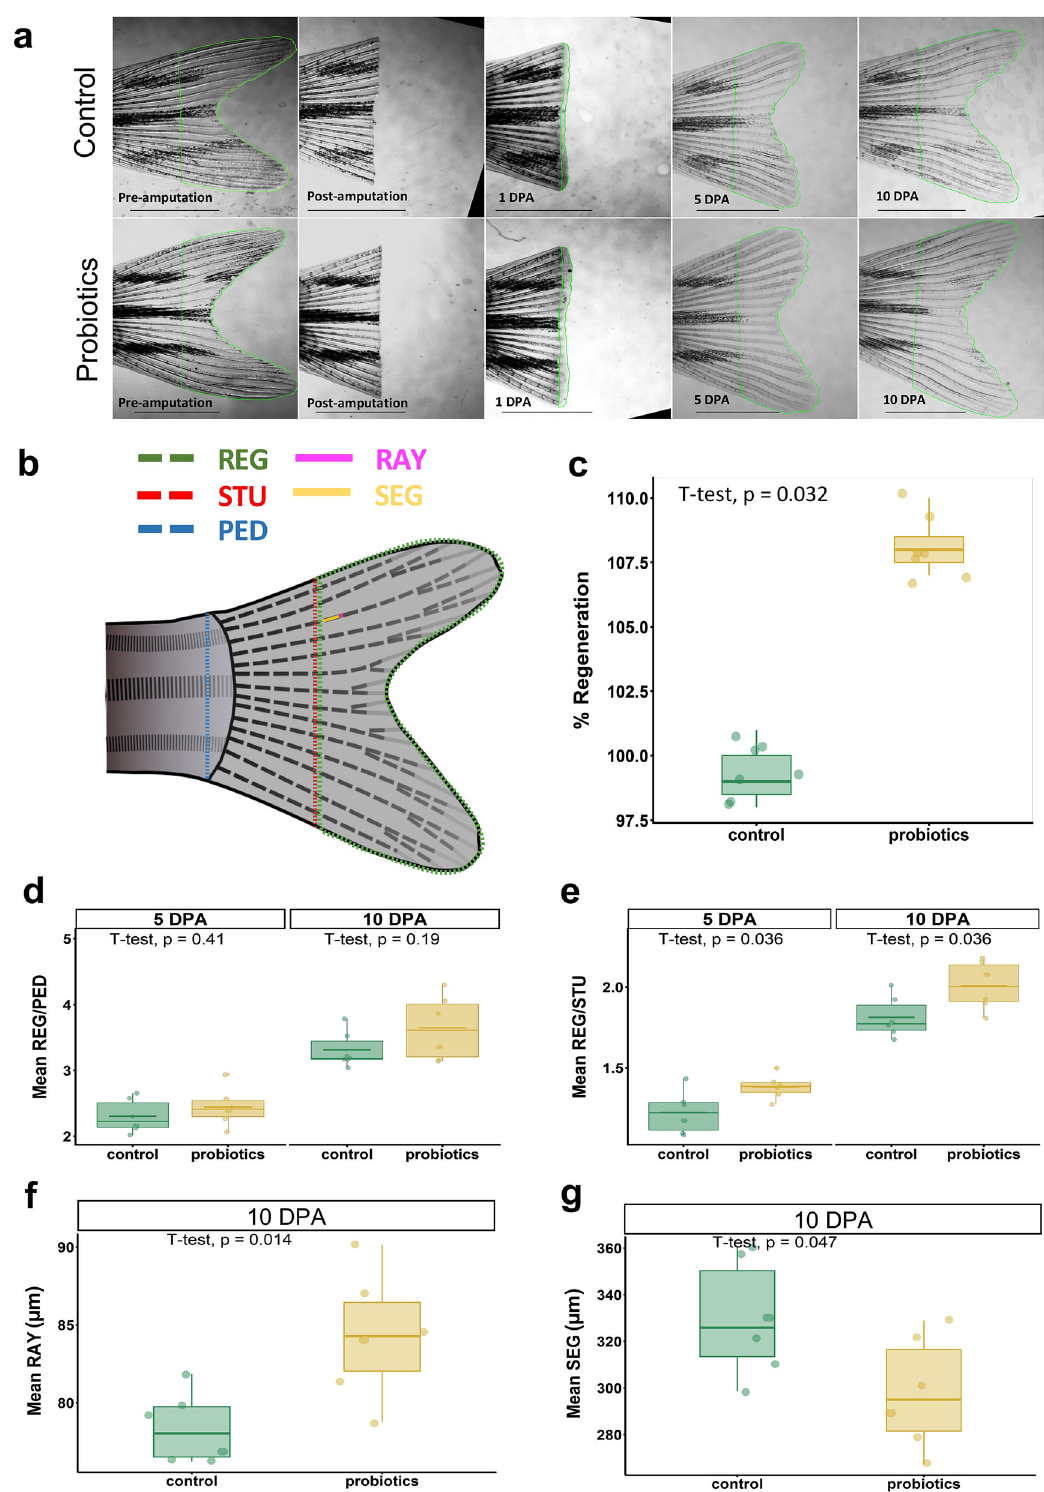
Figure 1. ( a ) Representative photographs showing the fins before amputation, post amputation and at 1, 5 and 10 DPA in control (C) (n = 7) and probiotic-treated (P) (n = 7) groups (Scale bar = 2,000 µm); ( b ) Picture of a representative amputated fin, showing the regenerated area (REG, green dotted tracing), the stump width or width of the amputation plane (STU, red dotted line), the fin ray width (RAY, pink line), the segment length (SEG, yellow line) and the peduncle width (PED, blue dotted line); ( c ) Statistical analysis of regeneration rate (expressed as %) between C and P groups calculated at 10 DPA with respect to the fin before amputation of the same fish. ( d – g ) Various morphometric parameters used to analyze the regenerated areas in C and P fins (n = 7 per group per time point) ( d ) Regenerated area (REG)/Peduncle width (PED) ratio; ( e ) Regenerated area (REG)/Stump width (STU) ratio; ( f ) Mean ray width (RAY) and ( g ) Mean segment length (SEG). T-test was used to analyze the differences among the groups. % Values were converted to respective decimal values before applying T-test and statistical significance was set at p <